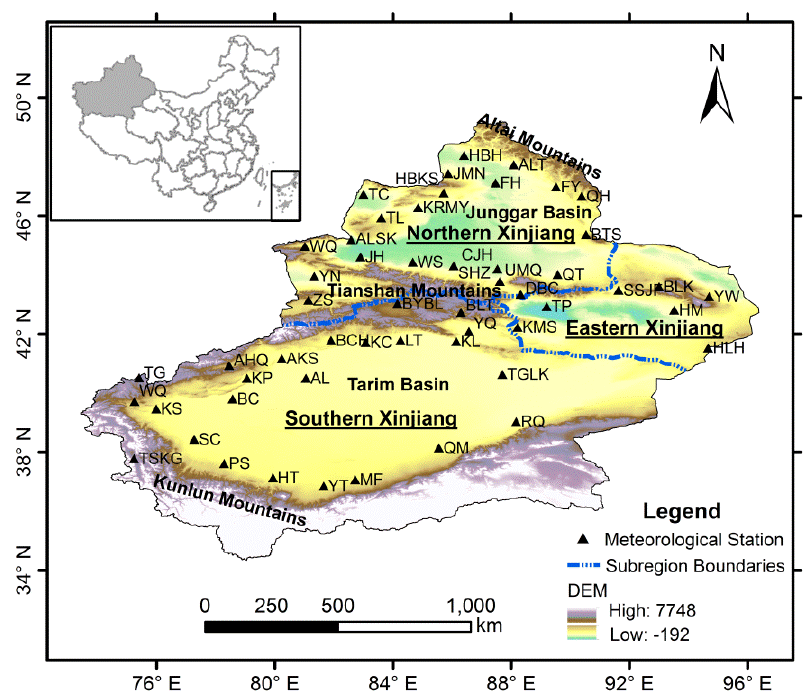
Figure 1. A map of Xinjiang and locations of meteorological stations.